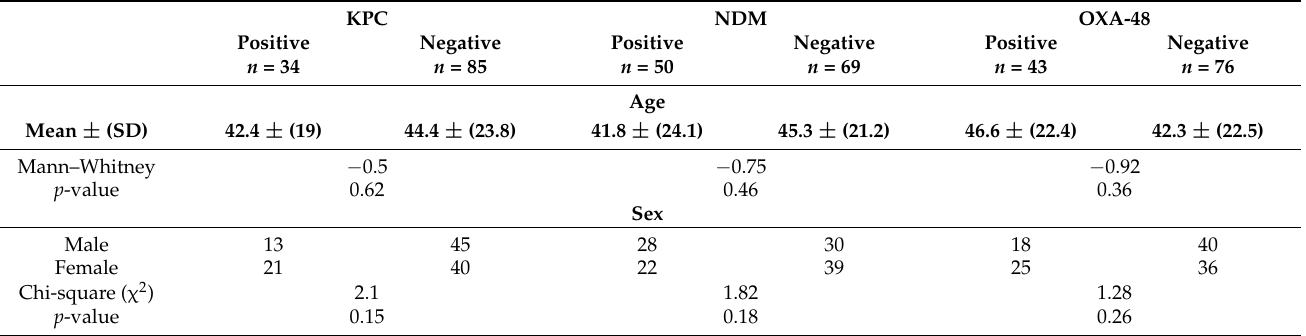
Table 6. Correlation between demographic characteristics of CRKP patients and the detected carbapenemase-encoding genes .